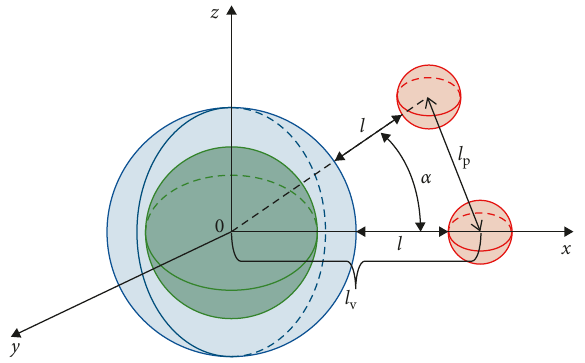
Figure 2: System of three